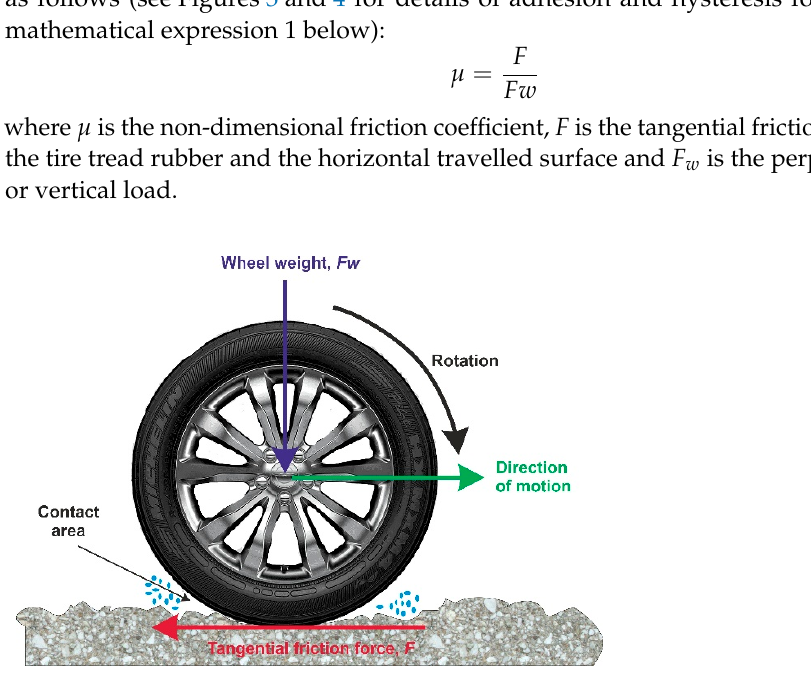
Figure 3. Typical sketch of forces acting on a rotating wheel (concept taken from [5,20]).